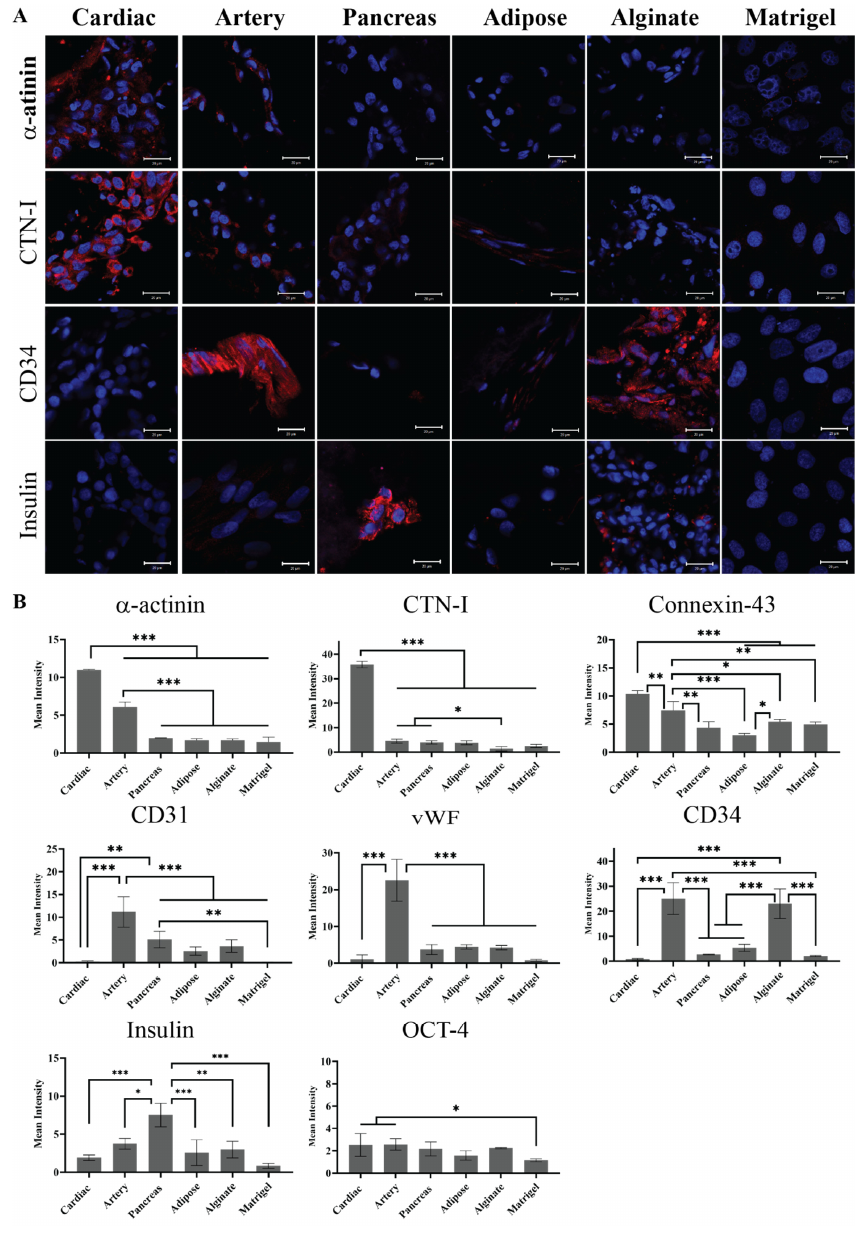
Figure 7. Spontaneous differentiation of hiPSCs on pECM hydrogels. ( A ) Immunostaining of spontaneously